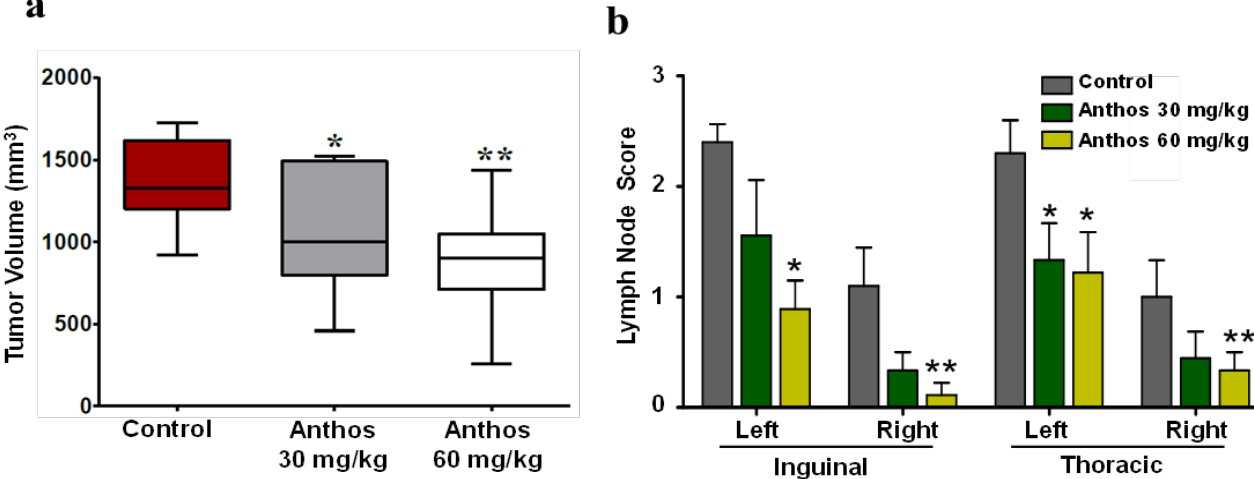
Figure 4. Effect of Anthos on tumor growth inhibition and lymph node metastasis: ( a ) NOD-Scid mice were inoculated (Ventral right, under second inguinal nipple) with MDA-MB-231 BC cells (2.5 × 10 6 cells) to produce an orthotopic tumor. When the tumor grew to ~120 mm 3 , animals were treated (oral gavage, three times a week) with Anthos (30 mg/kg or 60 mg/kg b.wt.). Control groups received PBS; ( b ) At euthanasia, lymph nodes were scored for size (as 0, 1+, 2+, or 3+). Data represent average ± SE ( n = 9–10). Data represent average ± SE ( n = 9–10). Statistical analysis was carried out using student’s t -test; * p < 0.05; ** p < 0.005.